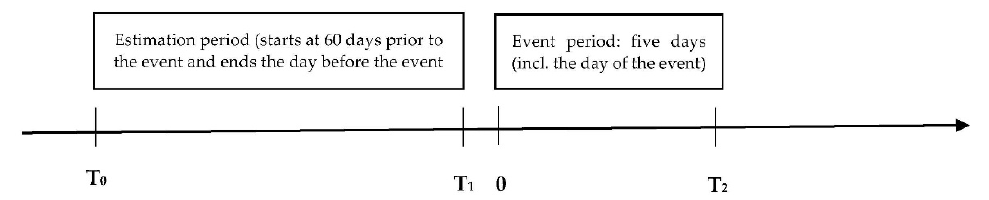
Figure 2. Event-Study Framework. Where the estimation period (T 0 –T 1 ), which starts 60 days before the event and ends one day prior to it, is used to provide estimates for the expected return of currency pair i at time t ( E ( R it )). This is related to Equations (2) and (3) below. The event period (0–T 2 ) which is 5 days including the day of the event denoted by 0 in the diagram, is used to obtain estimates for the abnormal (or excess) return of currency pair i at time t ( ARi,t ). This is related to Equations (2) and (4)–(7) below.